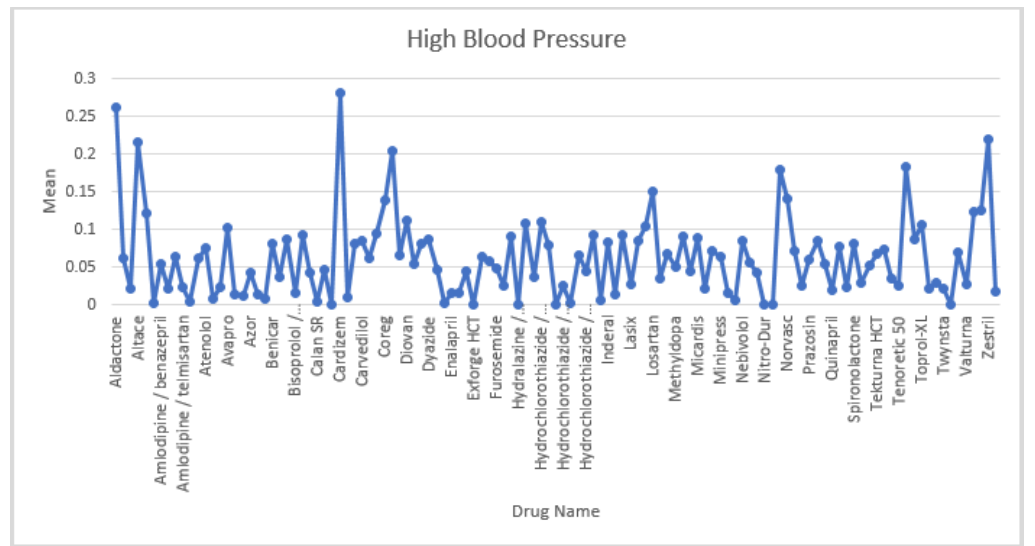
Figure 18. Top-rated drug recommendation results with acne condition.